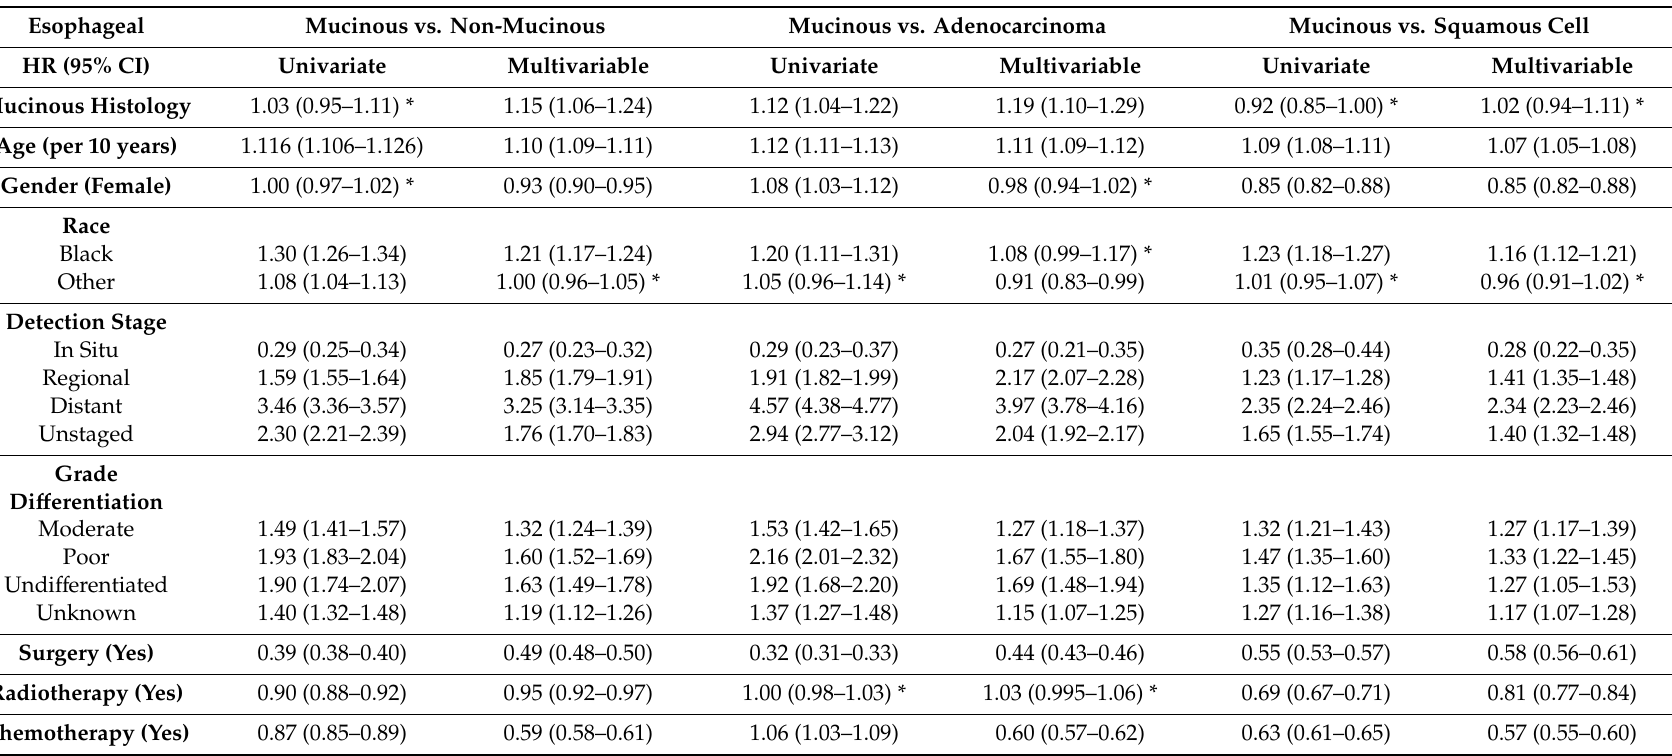
Table 20. Derived univariate and multivariable Cox-proportional hazard ratios (HR) of mortality for esophageal cancers. Esophageal Mucinous vs. Non-Mucinous Mucinous vs. Adenocarcinoma Mucinous vs. Squamous